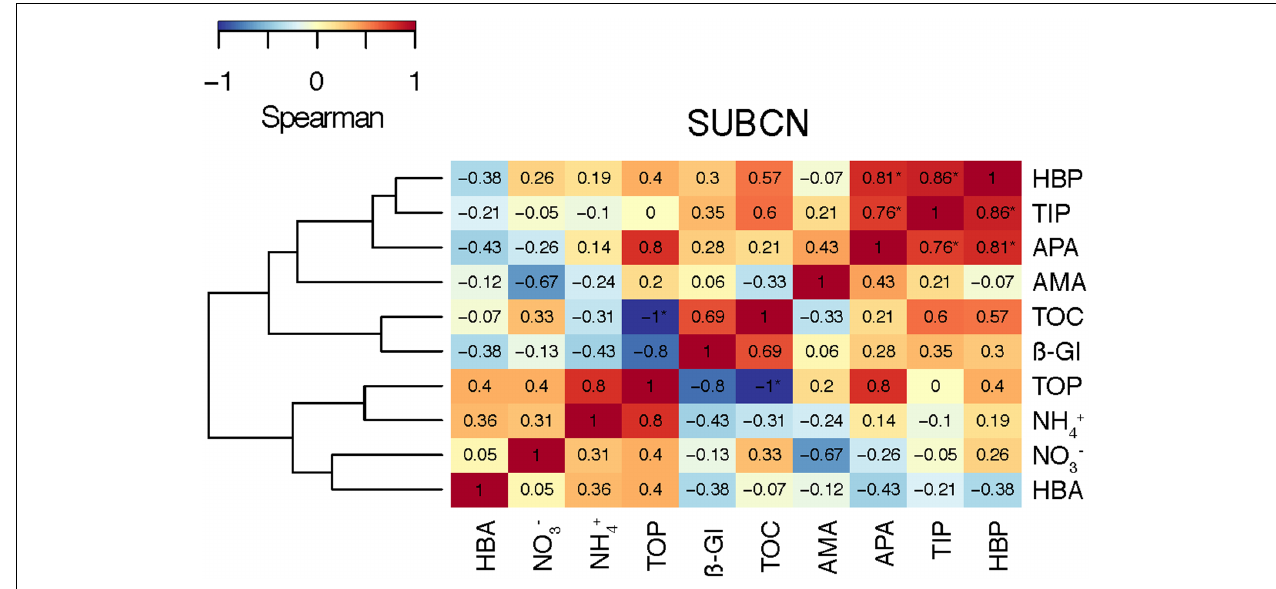
FIGURE 9 | Heat map showing the Spearman’s ρ coefficient between the biogeochemical variables in the SU experiment of BCN ( SUBCN ). Samples from both aerosol treatments (A and S), and both, F and NF, have been included ( N = 8). Significant correlations ( p < 0.05) are indicated with an asterisk ( ∗